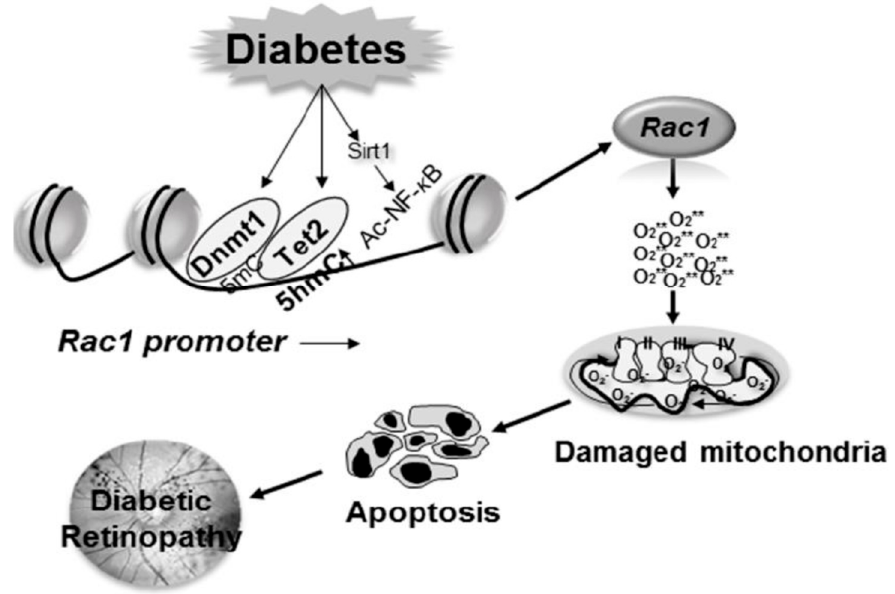
Figure 2. Epigenetic modifications of Rac1 promoter increase its gene transcription. Activation of Dnmts in diabetes increases methylation of Rac1 promoter, but concomitant increased binding of the hydroxymethylating enzyme Tet2, 5mC is hydroxymethylated, opening up the chromatin for the binding of the transcription factors. In addition, due to upregulation of SUV39H1, increase in H3K9me3 levels at the promoter further helps the recruitment of Dnmts and the methylation- hydroxymethylation process. Diabetes also inhibits Sirt1, which allows NF- k B to be acetylated, and facilitating the binding of the acetylated NF- k B at the Rac1 promoter, further helping in Rac1 transcription.